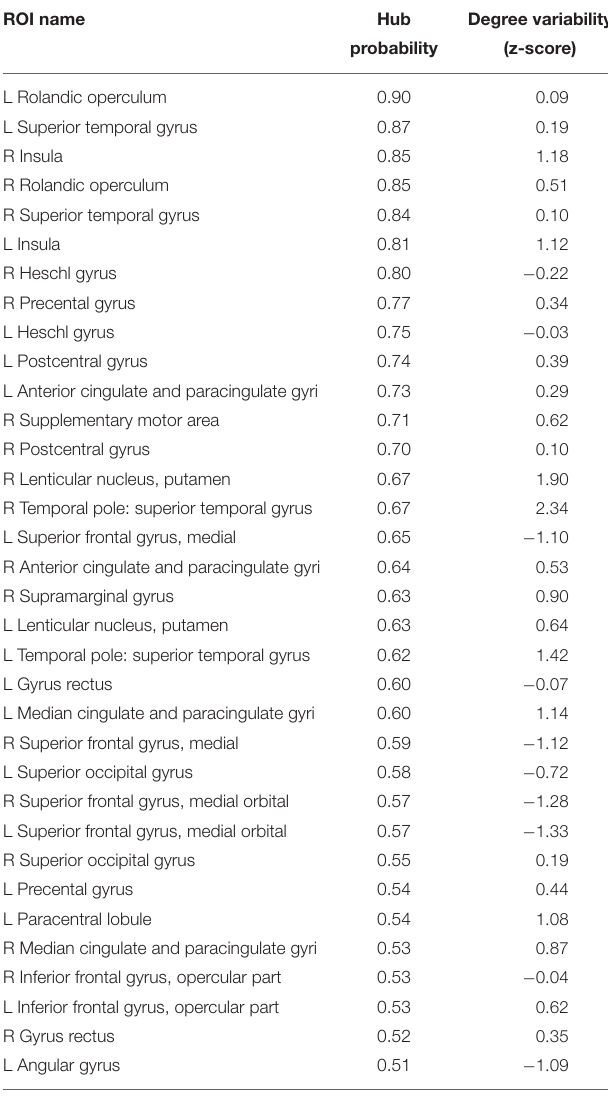
TABLE 1 | Functionally persistent hubs in dynamic brain networks